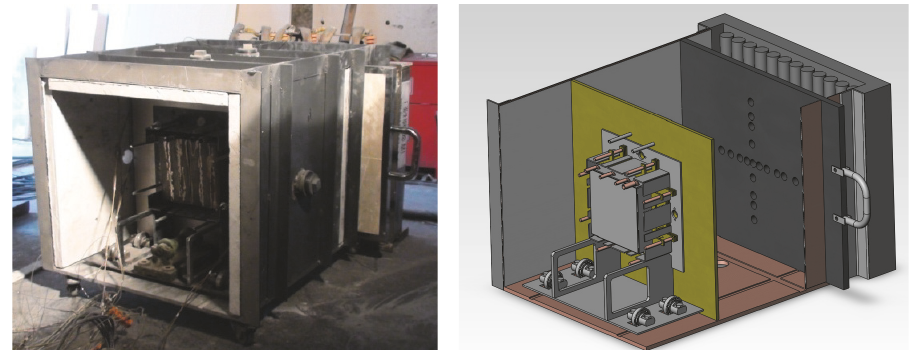
Figure 1: Schematic diagram and view of experimental chamber.